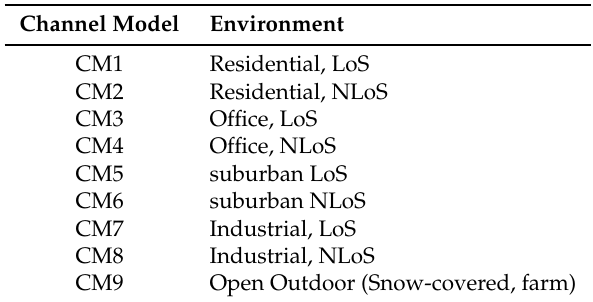
Table 1. Class of CMs